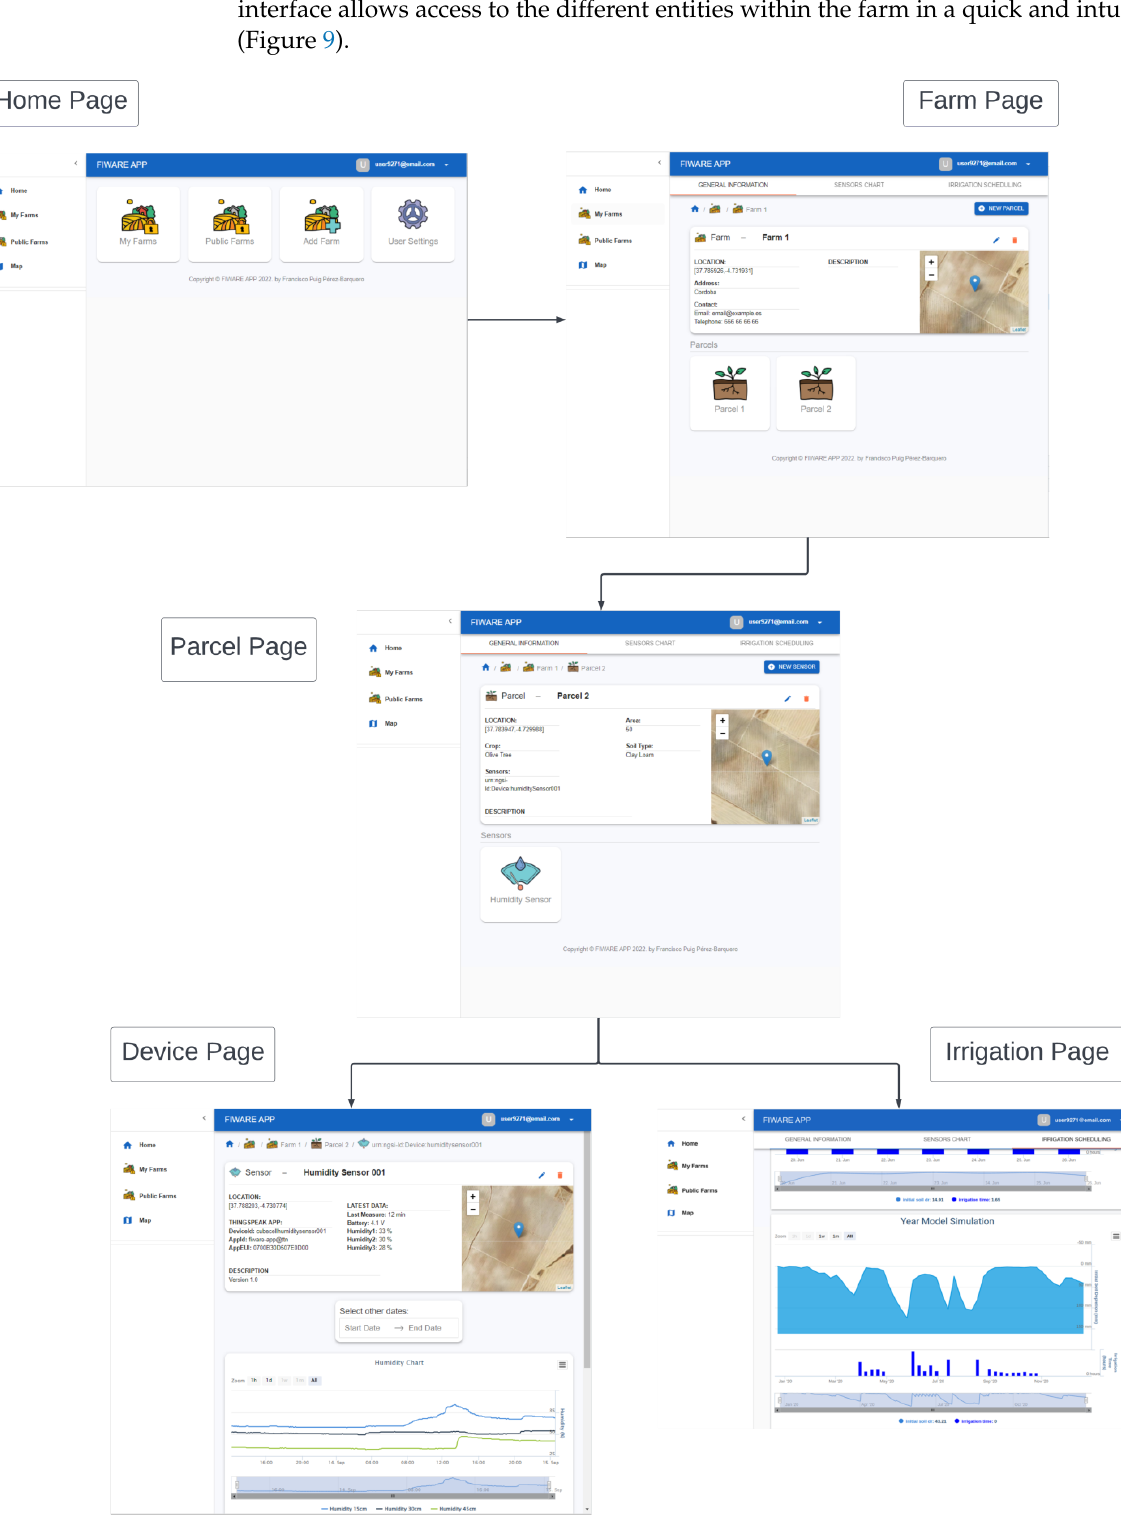
Figure 9. Main interface pages.